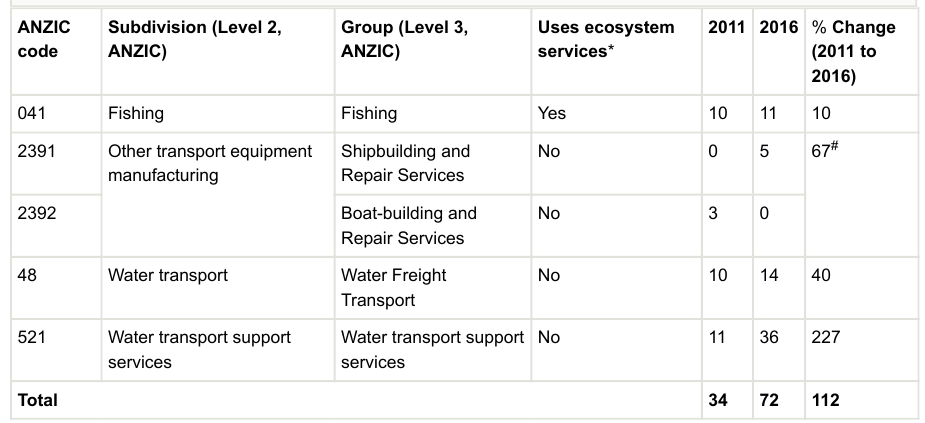
in employment was combined for ship and boat-building and repair